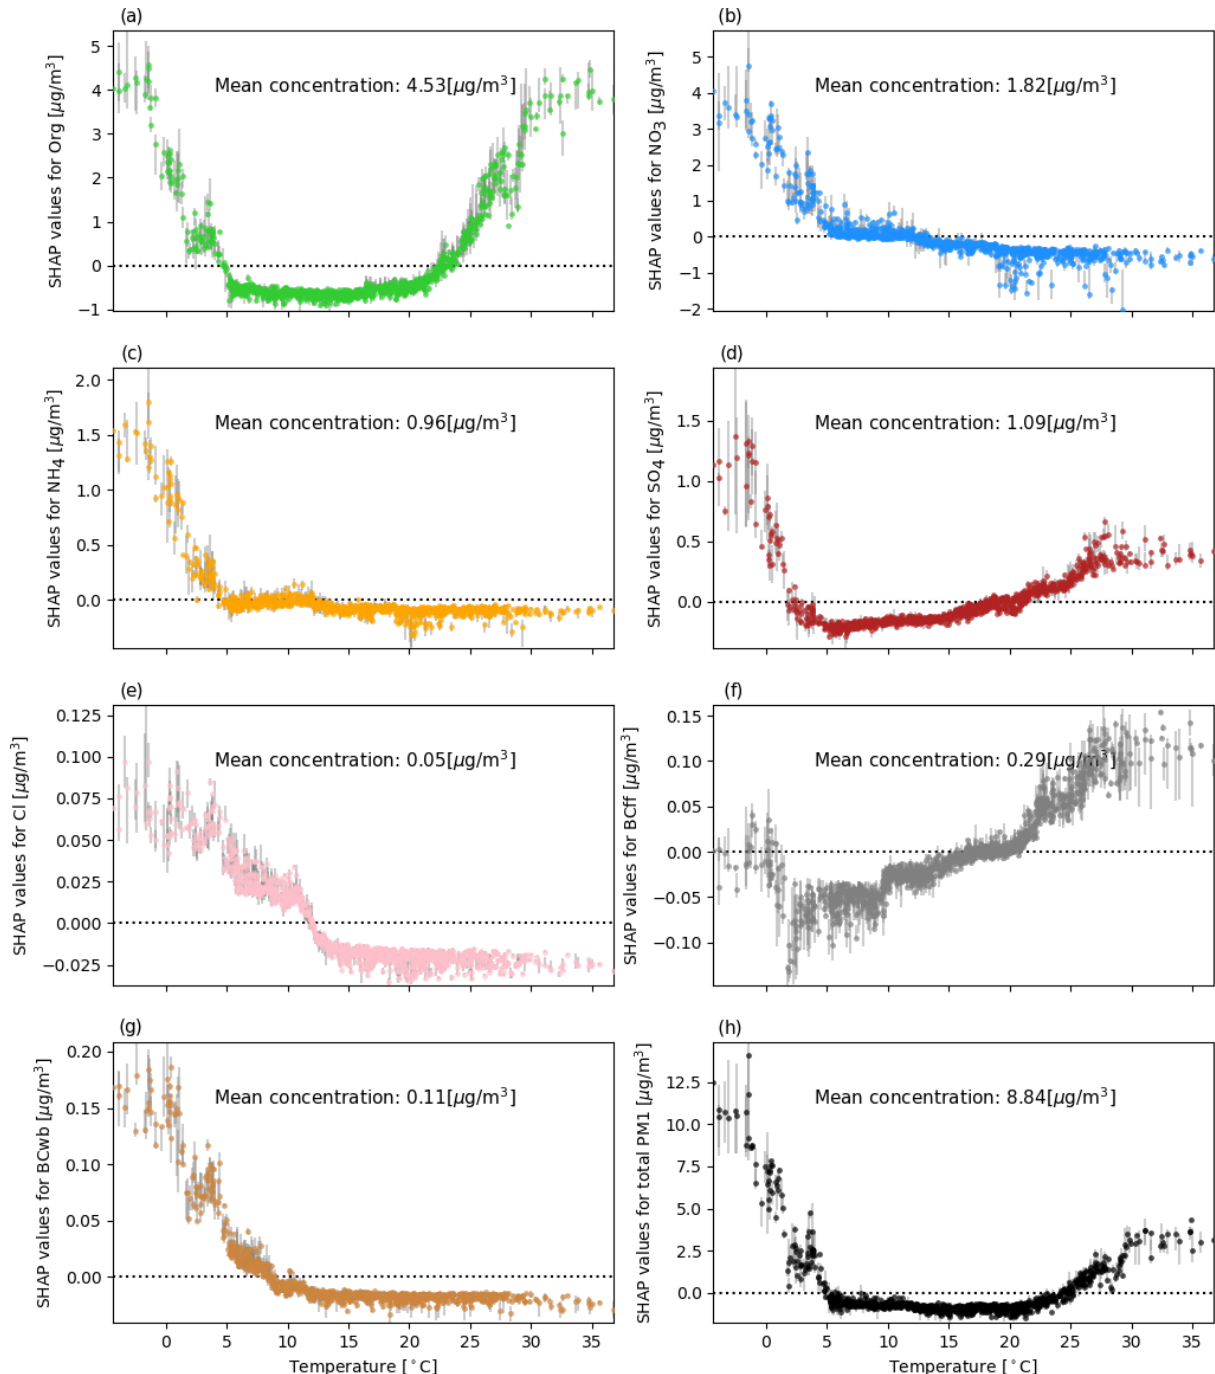
Figure 5. Air temperature SHAP values (contribution of temperature to the prediction of species and total PM 1 concentrations [µg/m 3 ] for each data instance) vs. absolute air temperature [ ◦ C]. Inter-model variability of allocated SHAP values is shown as the variance of predicted values between the 10 model iterations and plotted as vertical grey bars. The dotted horizontal line indicates the transition from positive to negative SHAP